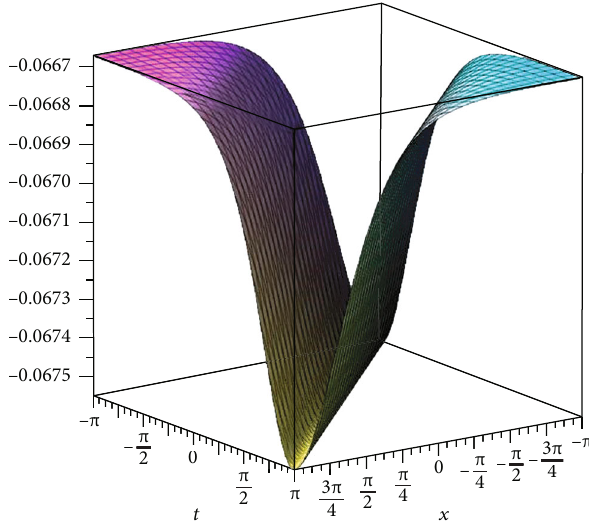
Figure 4: Graphical behavior for ϕ and s = 1 2